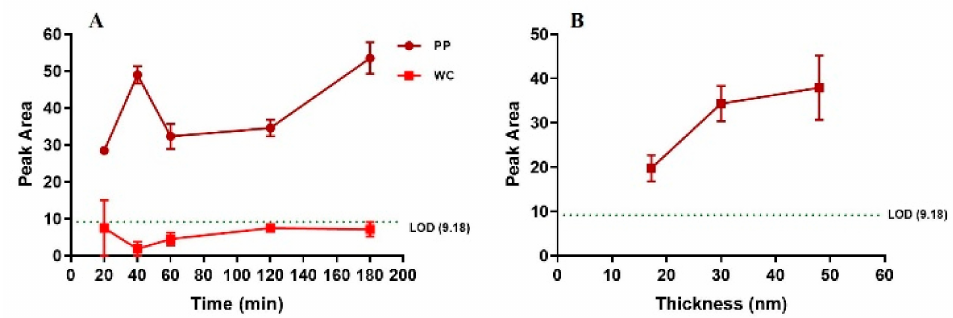
Figure 6. LIBS gold peak area of coatings incubated with SQ88 rock leachate as a function of incubation time for 30 nm PP coating and 6 nm WC coating ( A ) and as a function of coating thickness for PP coatings at 60 min incubation time ( B